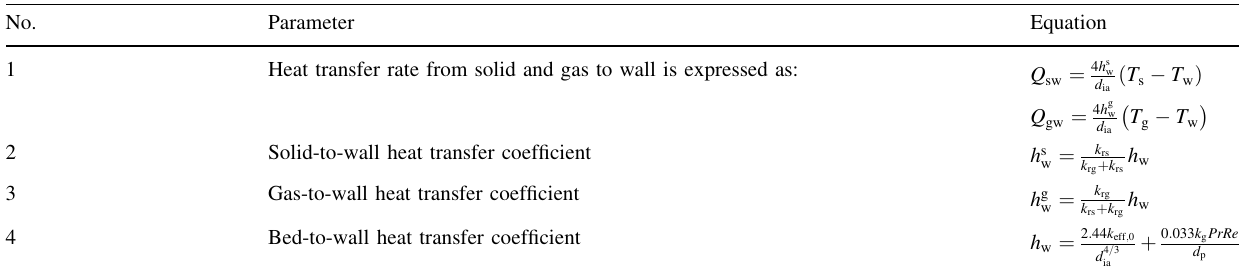
Table 10 Heat and mass transport correlations used in the present model (Green and Perry 1999; Kremer 2011) No.